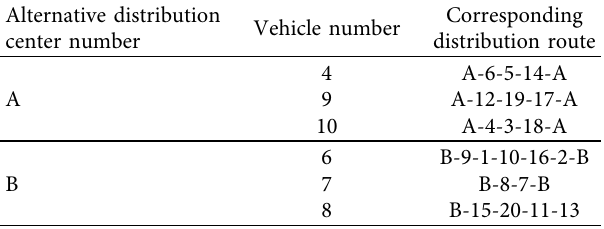
Table 4: Location, distribution vehicles, and route selection. Alternative distribution